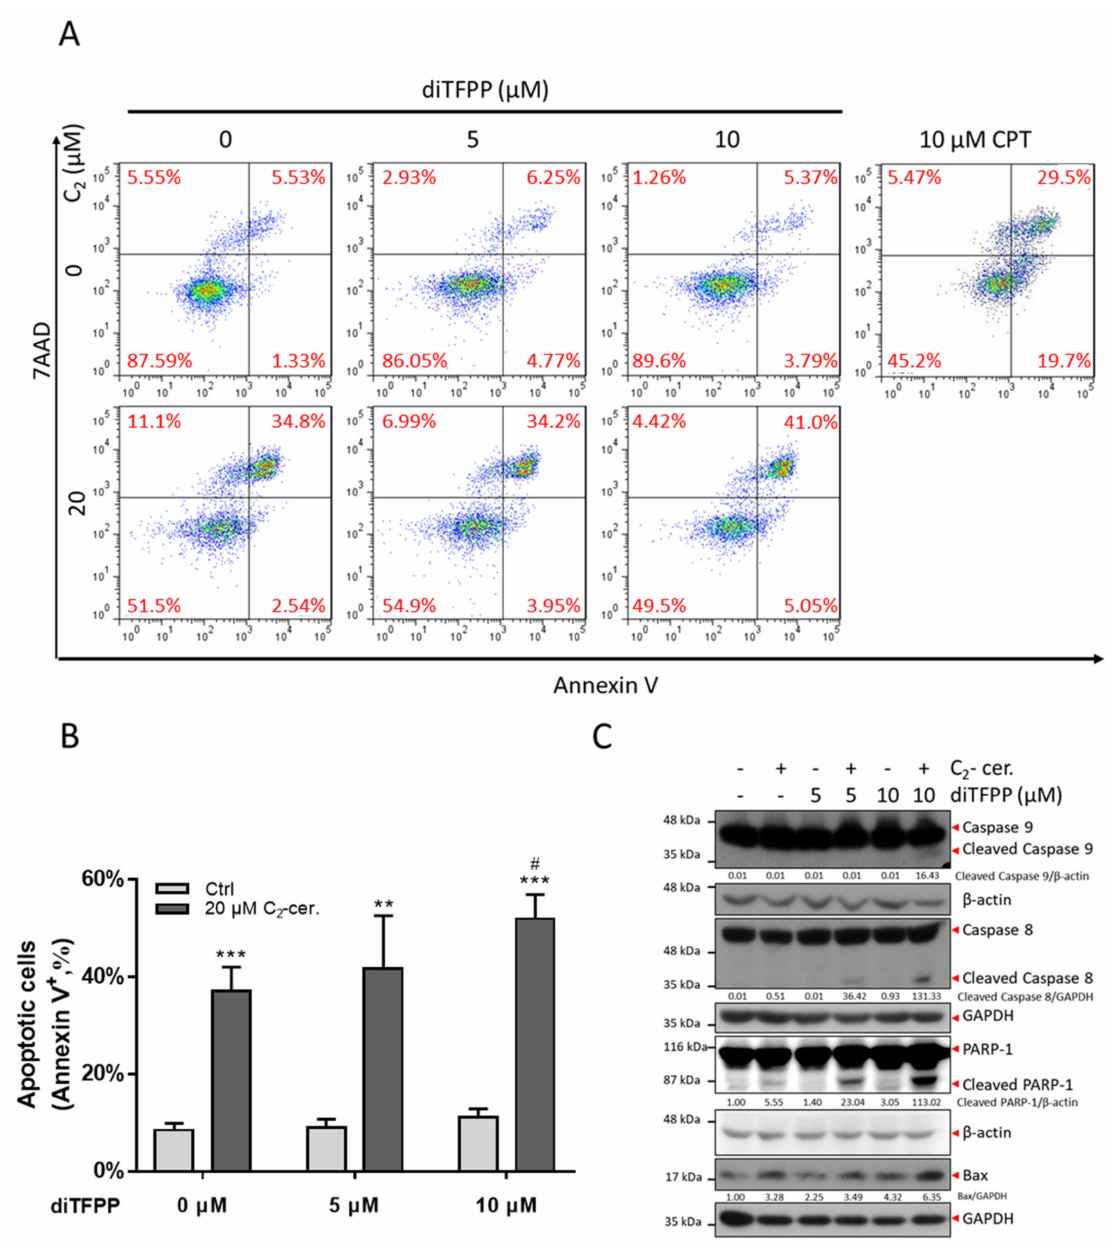
Figure 2. diTFPP promotes C 2 -ceramide-mediated cell death via apoptosis. ( A ) Annexin V/7AAD double staining indicated cell death in response to 24 h of diTFPP/C 2 -ceramide treatment. Treatment with 10 µ M CPT was considered the positive control. ( B ) Quantification of (A). n = 3, ** p < 0.01, *** p < 0.001 compared with the control; # p < 0.05 compared with the C 2 -ceramide only group. ( C ) Western blot analysis of apoptotic protein expression after diTFPP and C 2 -ceramide (C 2 -cer.) treatment. Cleaved caspase-9 and Bax expression indicated intrinsic apoptosis, cleaved caspase-8 indicated extrinsic apoptosis, and cleaved PARP-1 indicated the hallmark of apoptosis. GAPDH and β -actin as internal controls. The fold changes of cleaved caspases were normalized with their internal